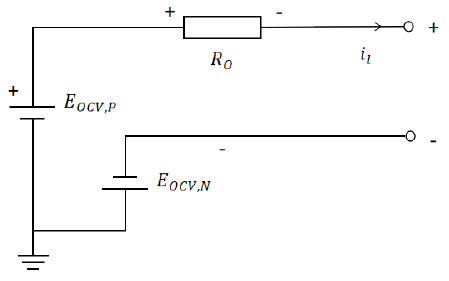
Figure 5. The R int model with electrode open circuit voltages. In Figure 5, E and E are the open circuit potentials of the positive and neg- , OCV P , OCV N ative electrodes, respectively.